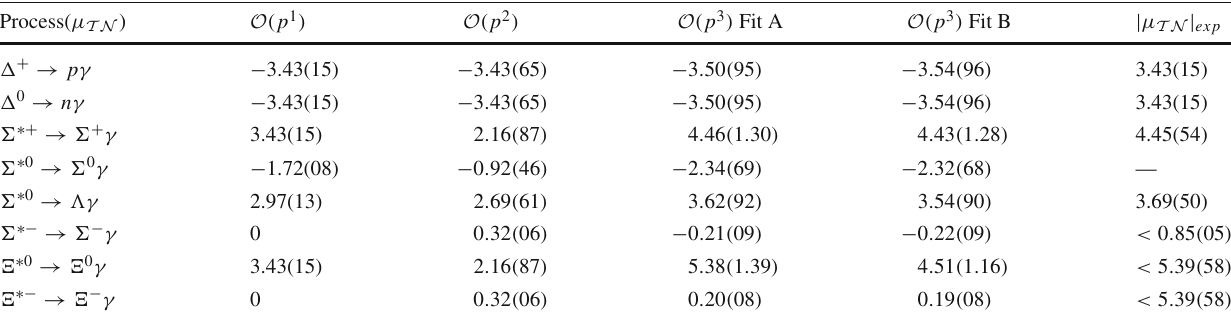
Table 4 The decuplet to octet baryon transition magnetic moments when the chiral expansion is truncated up to O ( p 1 ) , O ( p 2 ) , and O ( p 3 ) , respectively (in unit of μ N ). Actually, we use the branching ratios in PDG to extract the corresponding transition magnetic